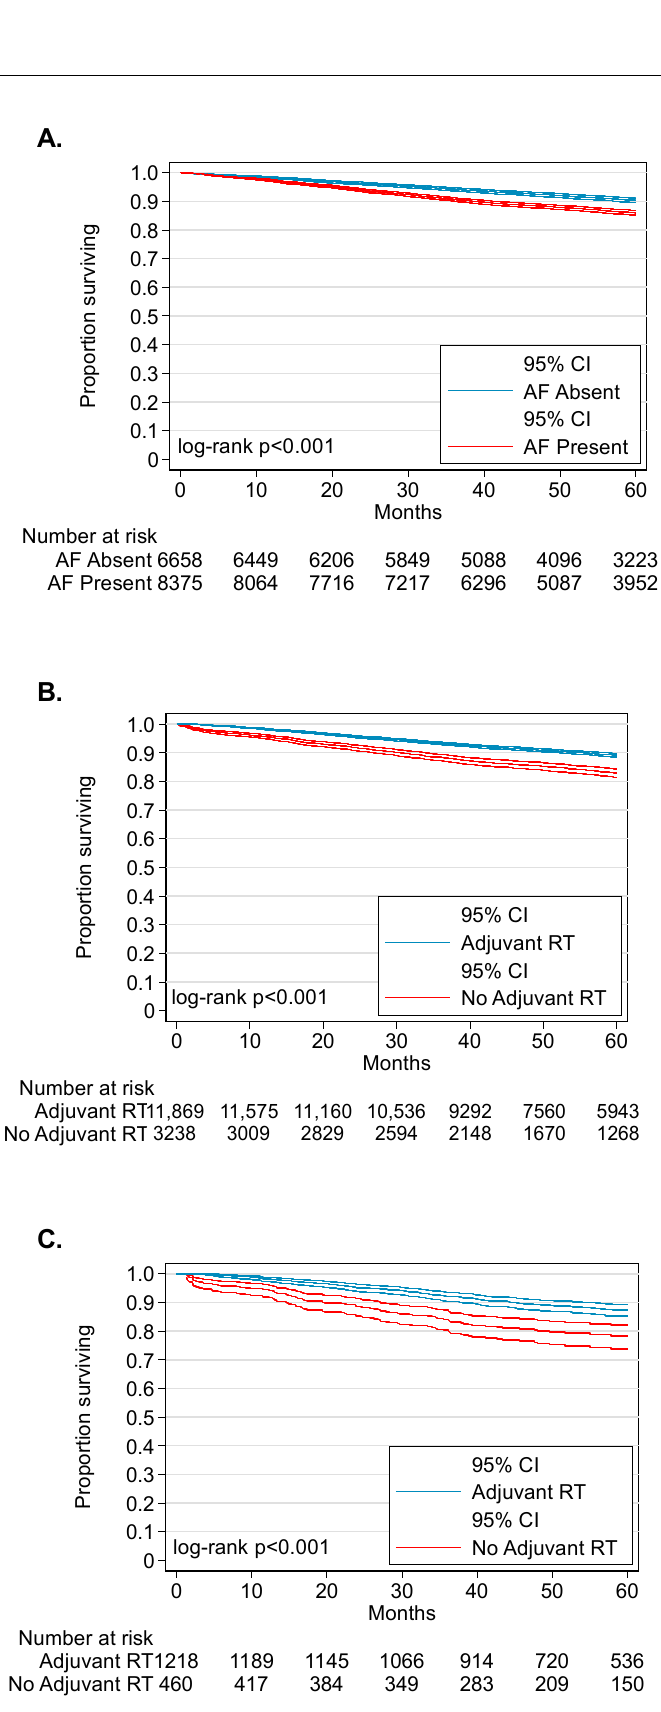
Figure 2. Kaplan–Meier Analyses ( A ) Influence of Adverse Features on Survival in HPV-OPC ( B ) Influence of Adjuvant RT on Survival in HPV-OPC ( C ) Influence of Adjuvant RT on Survival in AF ‐ HPV ‐ OPC.